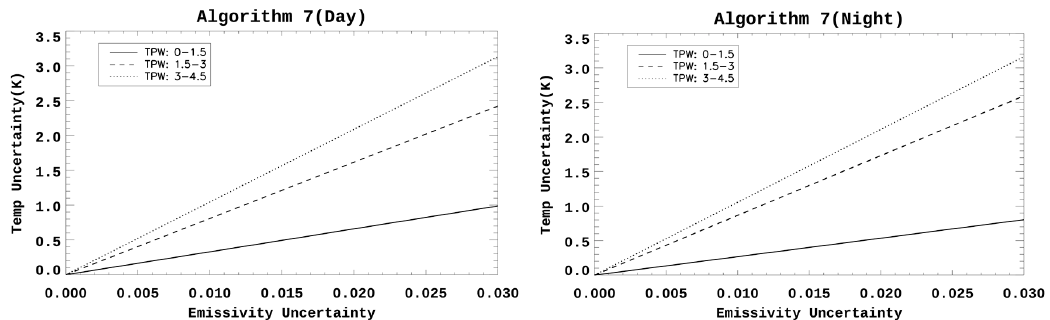
Figure 4. Uncertainty of the retrieved LSTs along with the surface emissivity uncertainty for the selected enterprise algorithm under day (left) and night (right) conditions, respectively. In the plots, it is assumed that emissivity difference is 0.005.